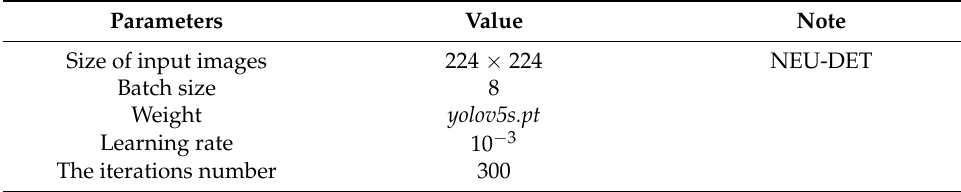
Table 2. The initialization parameters of improved YOLOV5.